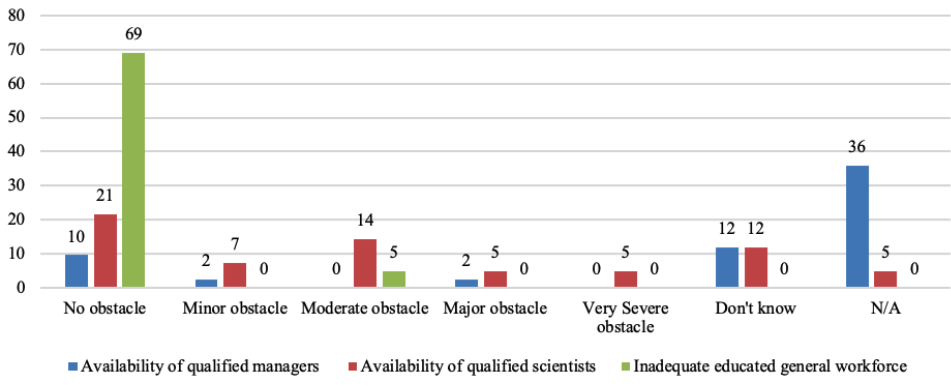
Figure 6: Elements of human capital